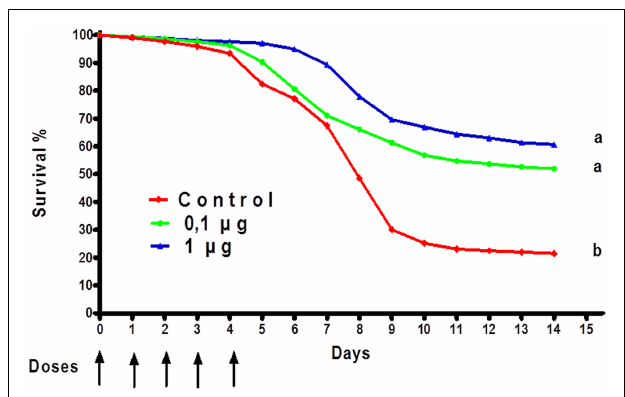
FIGURE 8 | Percentage of survival of Clarias gariepinus immunopotentiated withAFCo3a . Oral treatments of AFCo3a mixed with the first daily food for five consecutive days. Survival was determined every day for 15days. Statistical differences were determined by a Kruskal–Wallis/Mann–Whitney U -test. A p -value of < 0.05 was considered statistically significant and is represented by different letters.